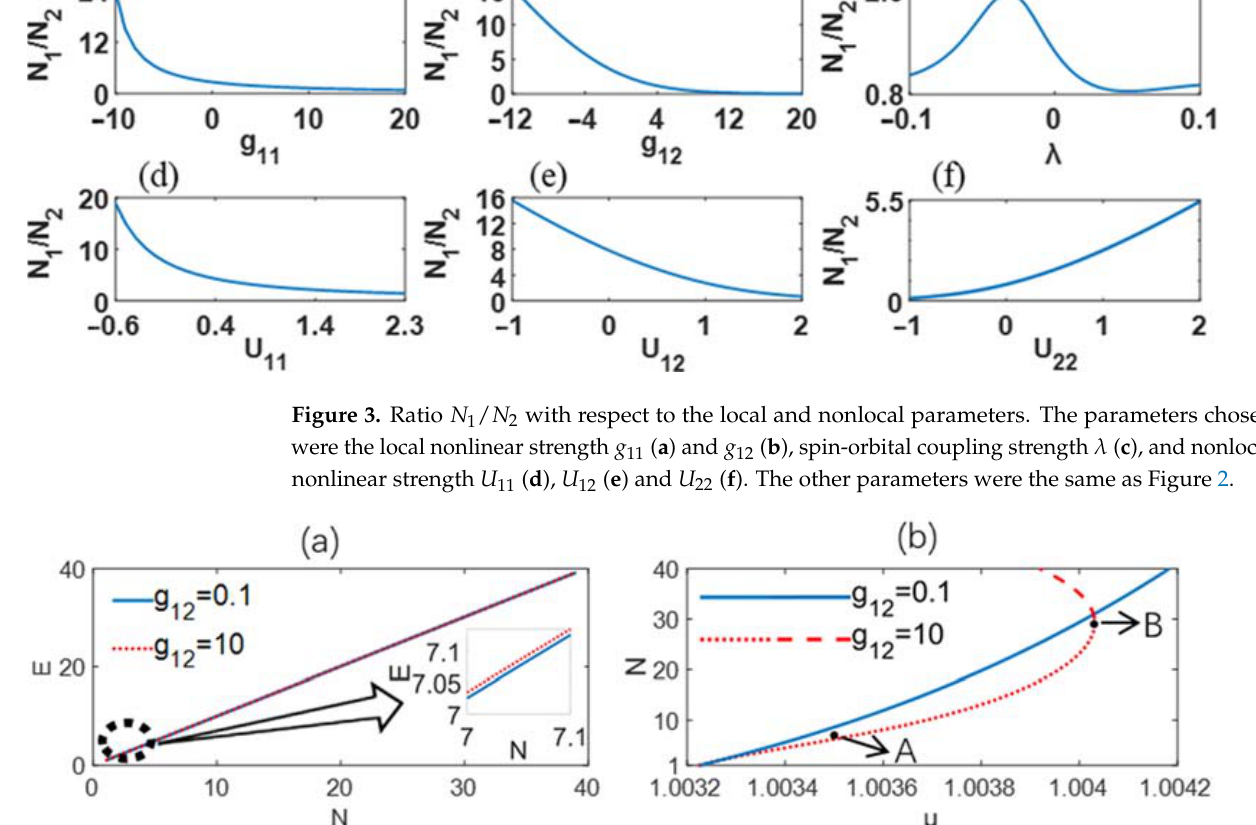
Figure 4. ( a ) Soliton energy versus total atom number N with different g 12 . ( b ) The relation of total atom number with the chemical potential µ . The blue solid (red) line represents the weak (strong) local nonlinear strength g 12 = 0.1, 10, respectively. Dot A represents the stable phase, while dot B represents the phase change of the stable solitons. The other parameters were the same as Figure 2. The density profile and spatial distributions of the zero-vorticity and vortex soliton pair are displayed in Figure 5, with both stable and unstable cases. In Figure 5a1,a2, the density of the zero-vorticity soliton was mainly distributed in the center, where the modulus of g ij and U ij was relatively small. With strong local and nonlocal nonlinear parameters, we observed an obvious diffraction beyond the center, which resulted in the collapse of the solitons, as seen in Figure 5b1,b2. For the vortex soliton, the density distributed in a circular ring instead of the center, as shown in Figure 5a3,a4. Similar to the zero-vorticity solitons, we also observed the diffraction of vortex solitons in an unstable case with strong local and nonlocal nonlinear parameters. When tuning the system parameters, the